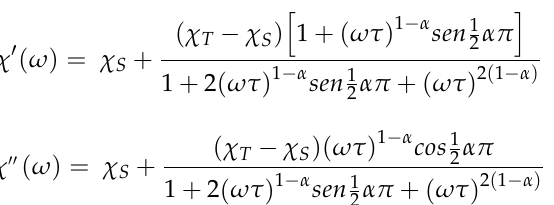
Figure 7. Frequency dependence of the out-of-phase AC susceptibility for 1 with an applied DC field of 800 Oe at different temperatures. Solid line is the best fit to the Debye model (Equation (3)).